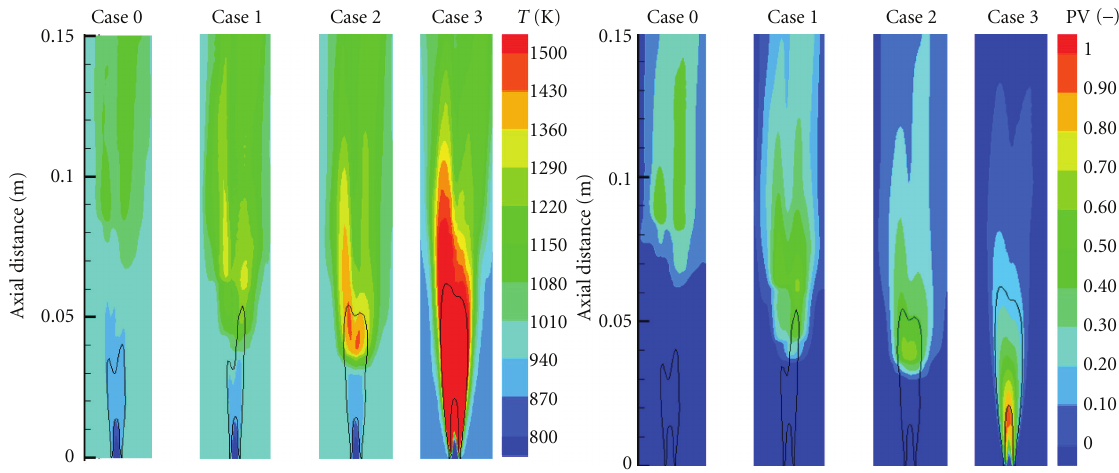
Figure 8: Time averaged contours of the resolved temperature (a) and the normalized progress variable PV (b). (Lines: stoichiometric (Z st = 0 . 17) and most reactive ( Z MR = 0 . 025) mixture